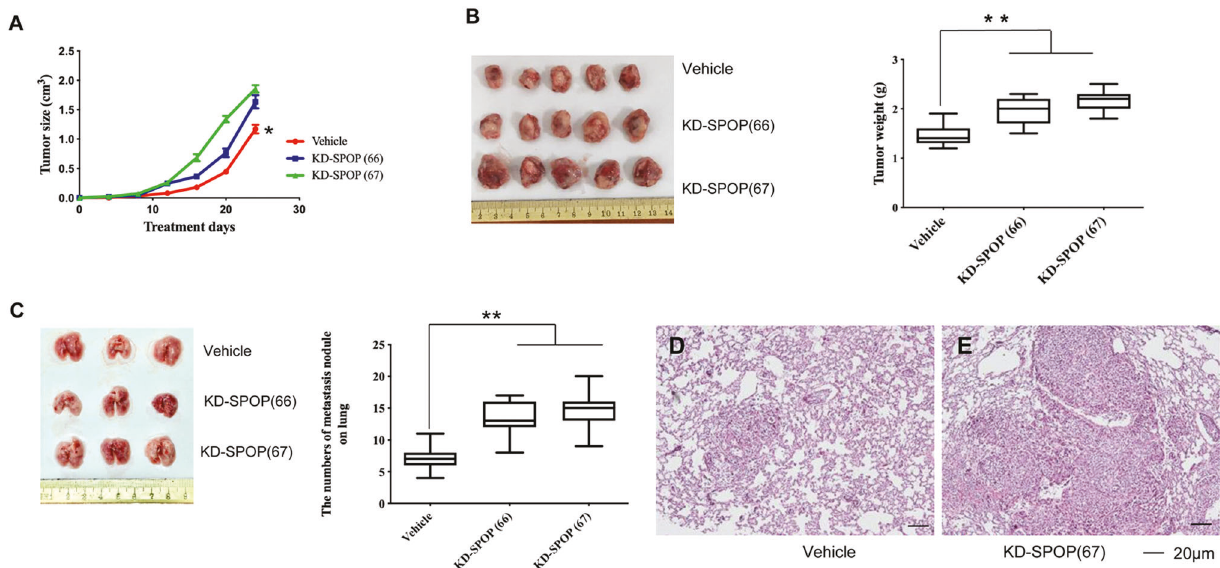
Fig. 3 Knock-down of SPOP promotes tumor progress in vivo. A Knock-down of SPOP promotes tumor growth and tumor size. P - value ≤ 0.05 was considered as a signi fi cant difference (*). B Knock-down of SPOP promotes tumor growth in weight at the endpoint of scari fi ed mouse. Left panel, representative tumor images; right panel, quantitative results. P -value ≤ 0.01 was considered as a signi fi cant difference (**). C Knock-down of SPOP promotes lung metastasis in vivo. Left panel, representative lung images; right panel, quantitative results of lung metastasis in vivo. P -value ≤ 0.01 was considered as a signi fi cant difference (**). D Representative lung tissue image of vehicle from C . E Representative lung tissue image of knock-down SPOP (clone 67) from C . KD-SPOP (66), knockdown SPOP in clone 66, KD-SPOP (67), knockdown SPOP in clone 67.